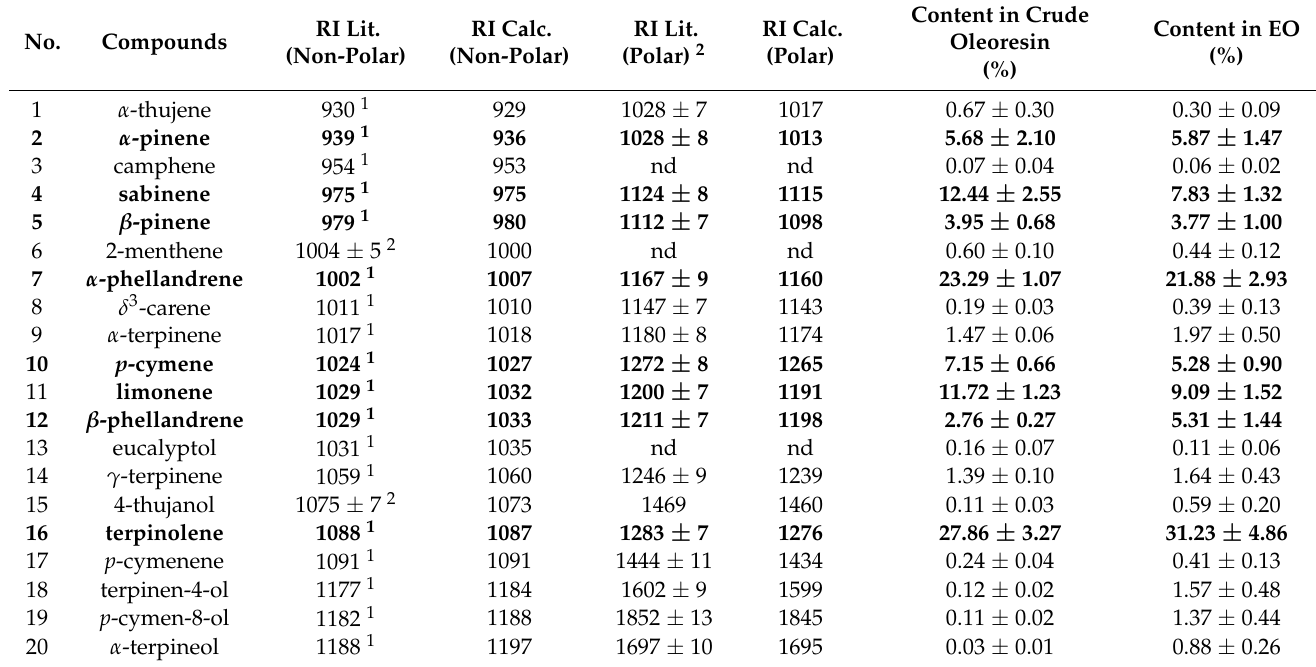
Table 2. Chemical composition of volatiles extracted from the crude oleoresin headspace of C. schweinfurthii collected in Gabon (Ntoum region, tree #1).